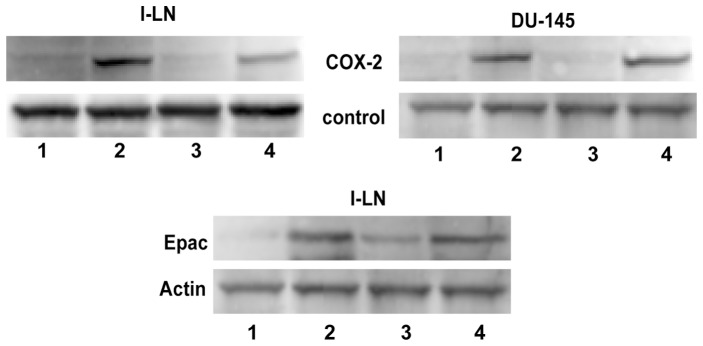
Effect of silencing Epac1 gene expression by RNAi on 8-CPT-2Me-cAMP-induced upregulation of COX-2 and Epac1 in prostate cancer cells.A representative immunoblot of COX-2 from three-independent experiments along with the protein loading control is shown. The lanes in COX-2 and Epac1 immunoblots of 1-LN and DU-145 cells are: (1) buffer + lipofectamine; (2) lipofectamine +8-CPT-2Me-cAMP (100 μM/30 min); (3) dsEpac1 RNA (100 nM/48 h) +8-CPT-2Me-cAMP (100 μM/30 min); and (4) scrambled dsRNA (100 nM/48 h) then 8-CPT-2Me-cAMP (100 μM/30 min).